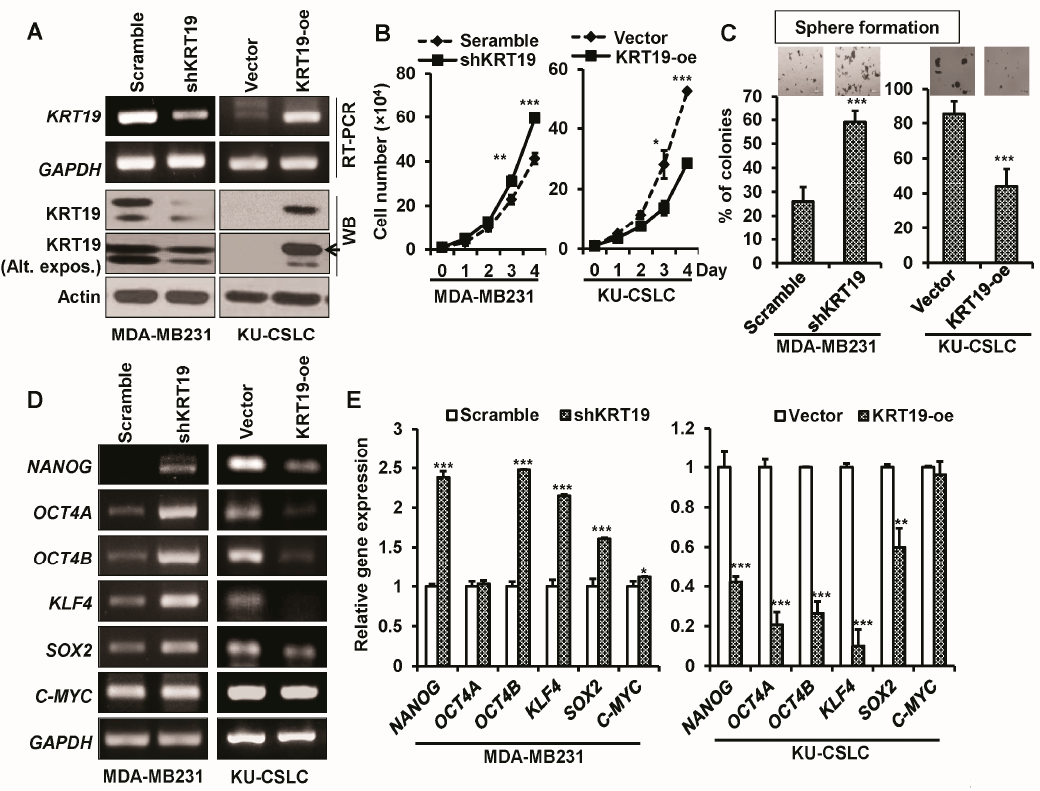
Figure 3. KRT19 could regulate cancer properties in MDA-MB231 or KU-CSLC cells. ( A ) mRNA and protein expression levels of KRT19 were analyzed using RT-PCR and WB in the MDA-MB231-scramble, MDA-MB231-shKRT19, KU-CSLC-vector, and KU-CSLC-KRT19-oe (keratin19-overexpression) cells, respectively. Alternative exposure (Alt. expos.) was used for KRT19 protein expression in indicated cells; ( B ) The effects of KRT19 -silencing or -overexpression on cell proliferation were analyzed by cell counting. Cells were enumerated up to four days in the indicated virus-infected cells. * p < 0.05; ** p < 0.01; *** p < 0.001. ( C ) Cells were cultured in sphere-forming media (SFM) using non-coated plates. The spheres were stained in indicated cells by crystal violet and were counted on day five. The spheres of the crystal violet stained cells were captured by phase contrast microscopy and presented as a percentage (%) of colonies. *** p < 0.001. ( D , E ) mRNA expression levels of stemness marker genes ( NANOG , OCT4A , OCT4B , KLF4 , SOX2 , and C-MYC ) were analyzed in the indicated cells using RT-PCR analysis. The specific band intensity was measured by the scanning densitometry program in ImageJ and normalized to that of a housekeeping gene, GAPDH . * p < 0.05; ** p < 0.01; *** p < 0.001.